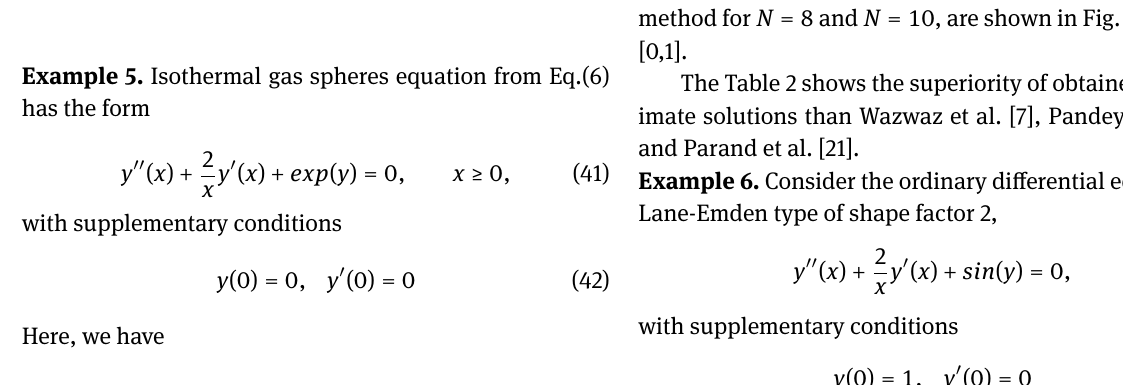
Fig. 4: Plot of obtained solution y(x) for N = 8, N = 10 and exact solution for example 4.